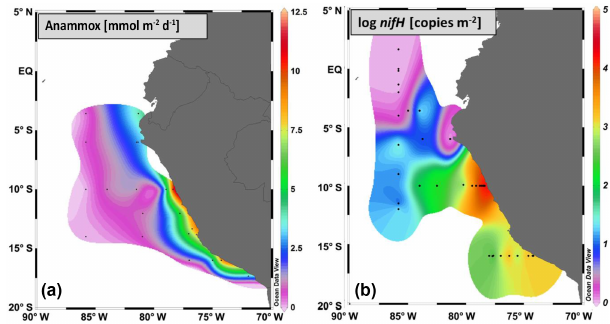
Figure 2. Co-occurrence of anammox as determined by rate mea- surements and the key functional marker gene for N 2 fixation, nifH , in the ETSP OMZ (modified from Kalvelage et al., 2013, and Löscher et al.,